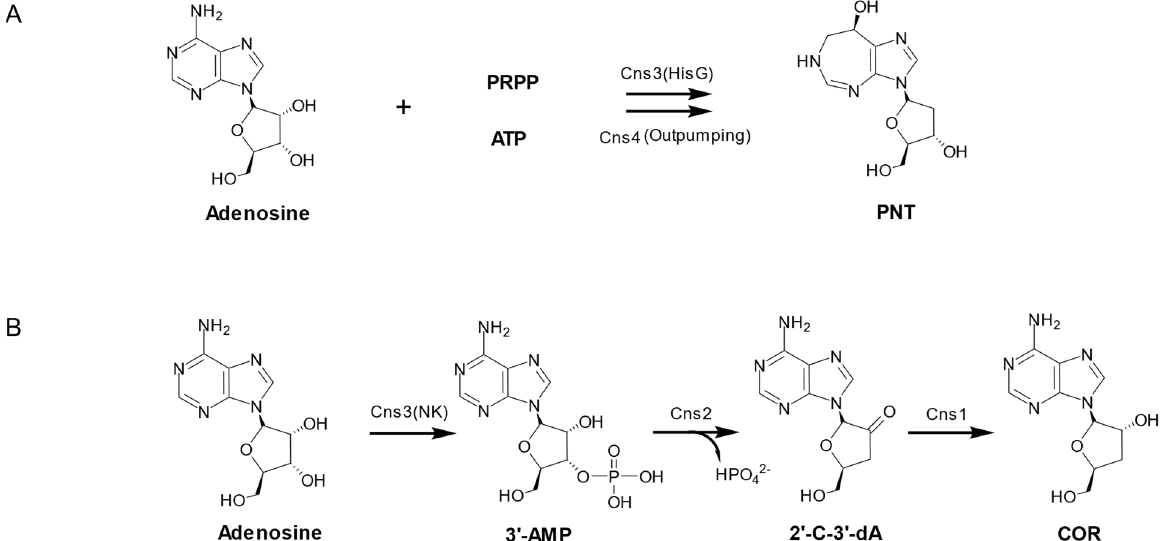
Figure 6. Biosynthesis pathway of PNT and COR in the Cordyceps militaris (modified from reference [12]). ( A ): biosynthesis pathway of PNT. ( B ): biosynthesis pathway of COR. The solid arrows indicate that this step is a determination process.